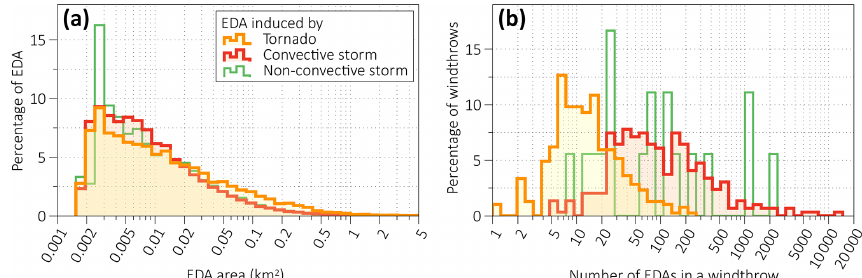
Figure 14. Distribution of (a) the size of EDAs for different types of windthrows and of (b) a number of EDAs within one windthrow.